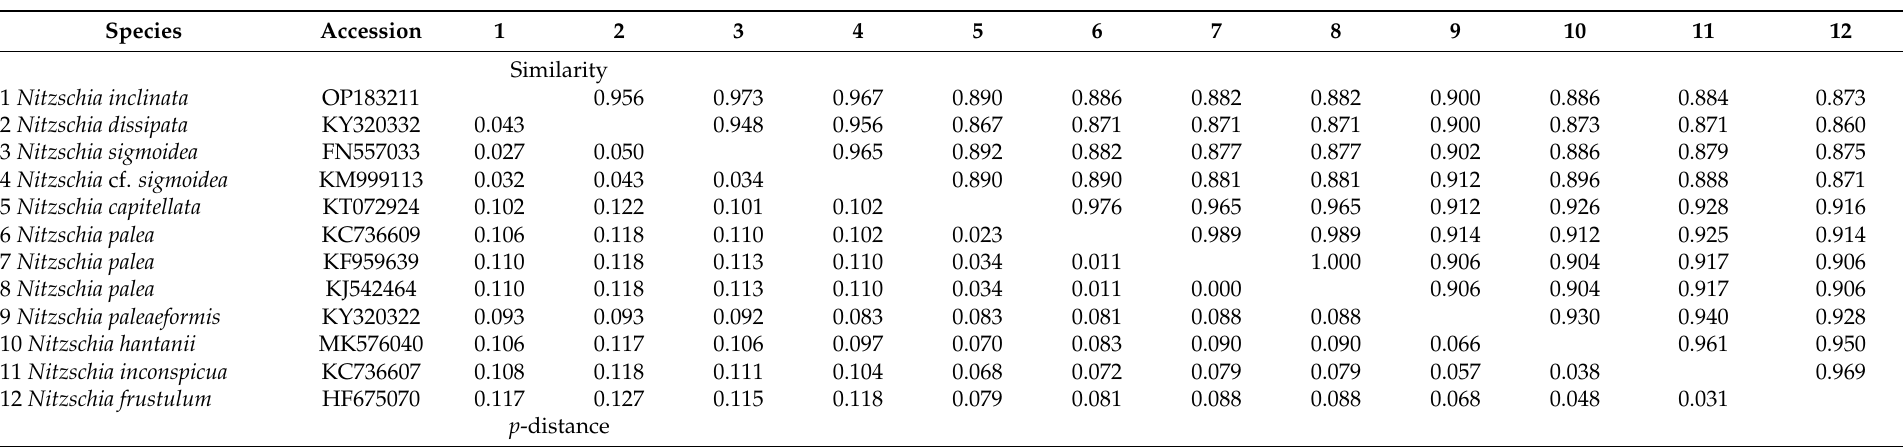
Table 10. Similarity scores and genetic distances among 12 aligned sequences (557 bp) of Nitzschia species based on rbcL